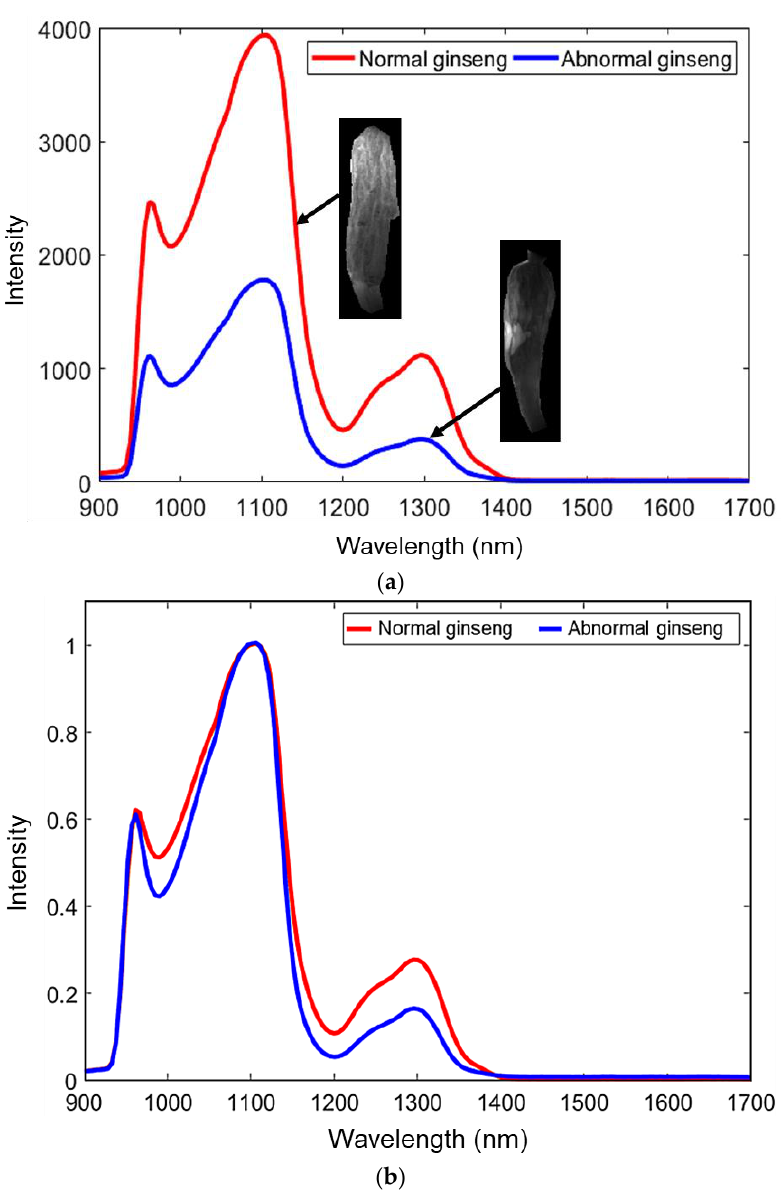
Figure 4. ( a ) Raw spectrum and corresponding hyperspectral images of normal and abnormal ginseng samples; ( b ) normalized spectrum of normal and abnormal ginseng samples.